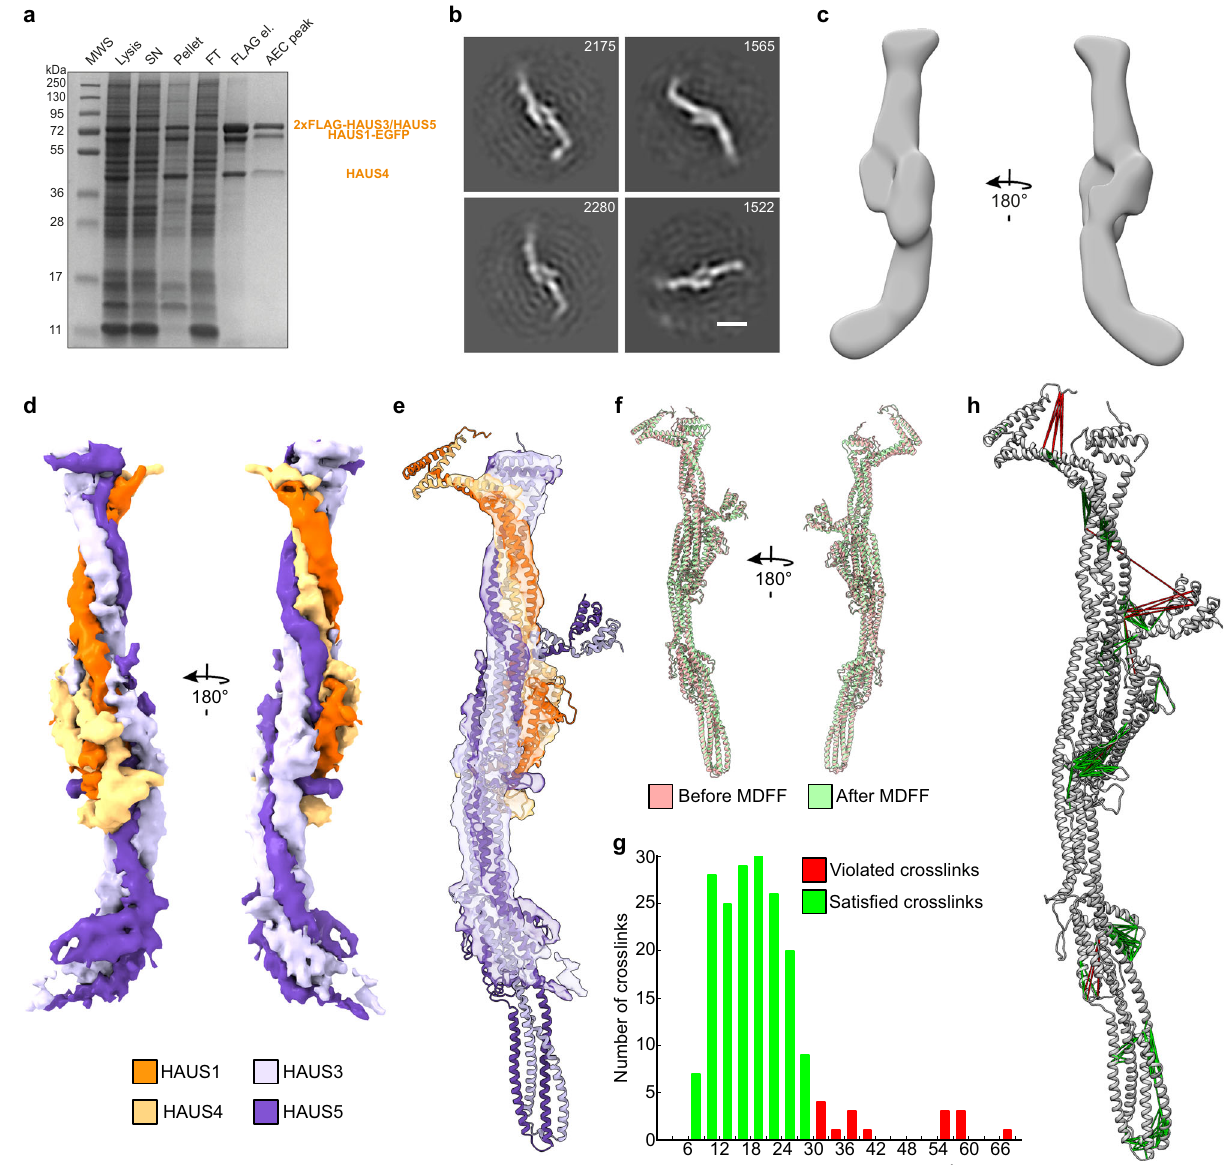
Fig. 2 | Cryo-EM structural analysis and crosslinking mass spectrometry vali- date the predicted TIII models. a SDS-PAGE analysis of the puri fi ed augmin TIII subcomplex. MWS: molecular weight standard; Lysis: Cell lysate; SN: supernatant; Pellet:cellpellet;FT: fl ow-throughafterincubationwithFLAGbeads,FLAGel.:FLAG elution; AEC peak: peak fraction after anion exchange chromatography (Supple- mentary Fig. 3). Puri fi ed proteins are indicated (orange). Augmin TIII tetramer puri fi cationandSDS-PAGEanalysiswererepeatedatleasttwicewithsimilarresults ( n =3 experiments). b , c Negative stain-EM analysis of augmin TIII. b Selected 2D class averages, particle numbers are given, scale bar 10nm. c 3D reconstruction of